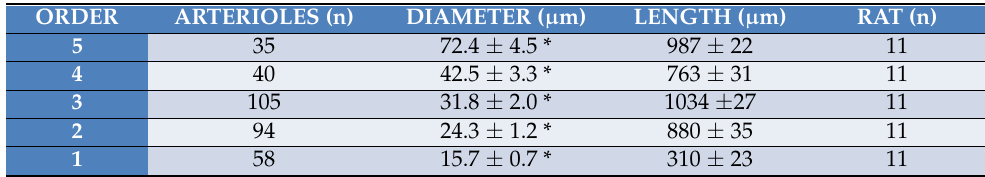
* p < 0.01 vs. different